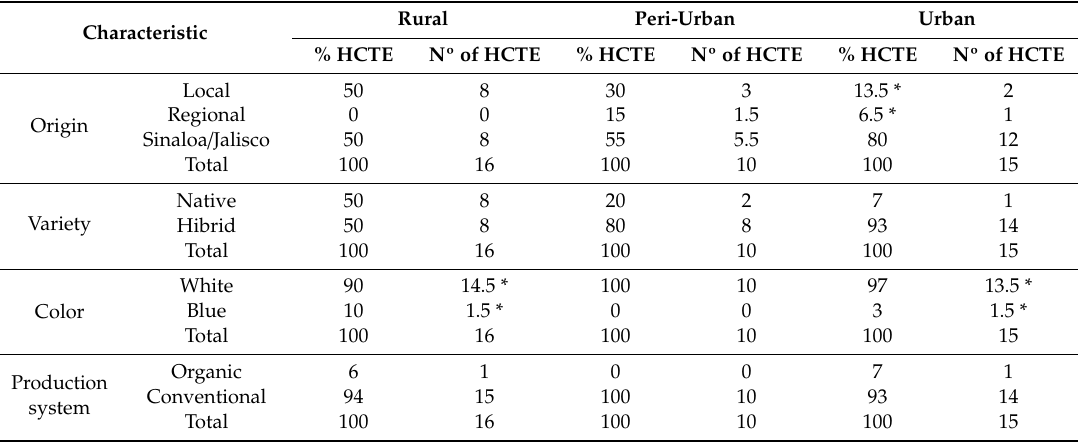
Table 1. Main characteristics of maize for handmade comal tortillas (HCT) in rural, peri-urban, and urban